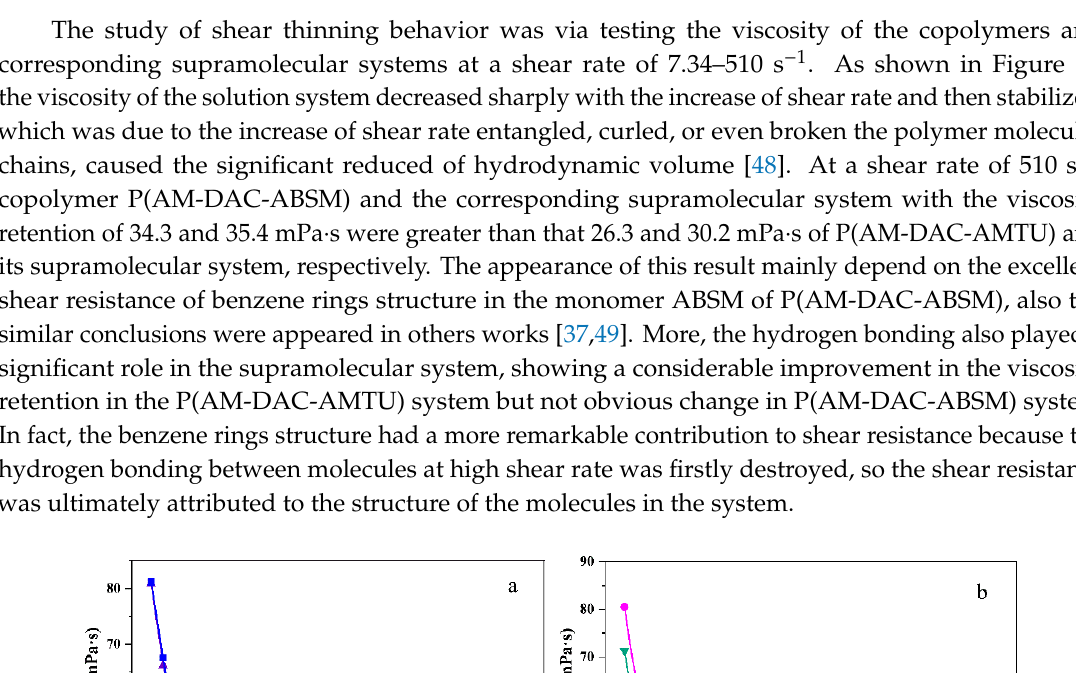
Figure 9. Cuttings recovery rate of different systems.